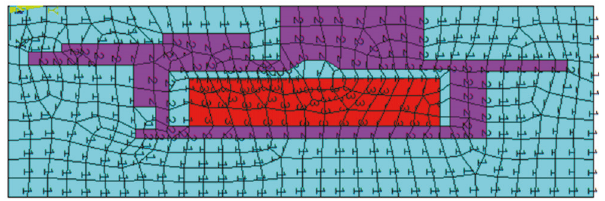
Figure 3: The proportional electromagnet